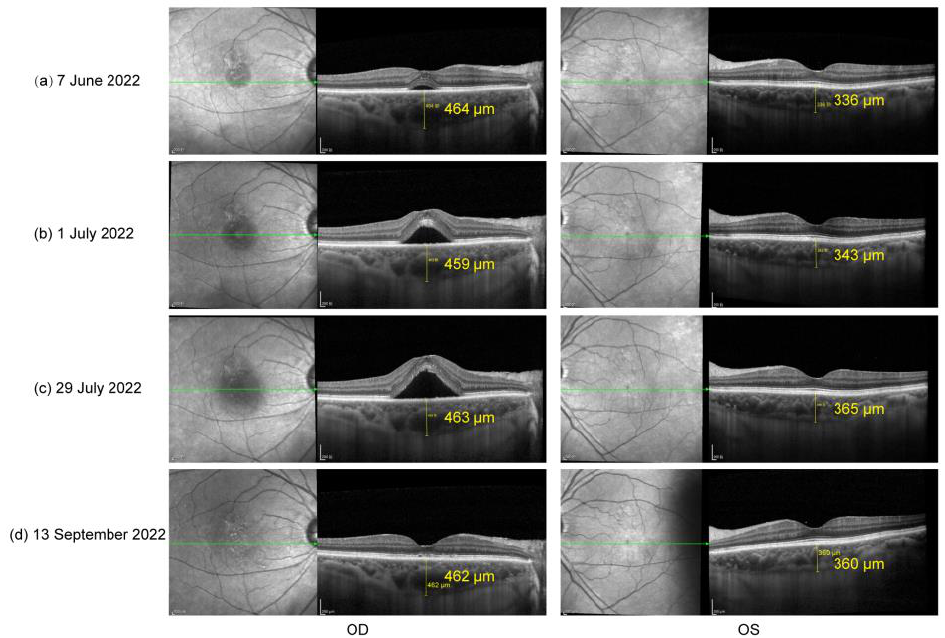
Figure 1. ( a ) Optical coherence tomography (OCT) on 18 January 2022: serous retinal detachment (SRD) and choroidal thickening OU; ( b ) OCT on 26 January 2022: significant reduction in subretinal fluid and relief of choroid edema OU; ( c ) OCT on 25 February 2022: little subretinal fluid in OD and a total recover of retinal structure in OS.